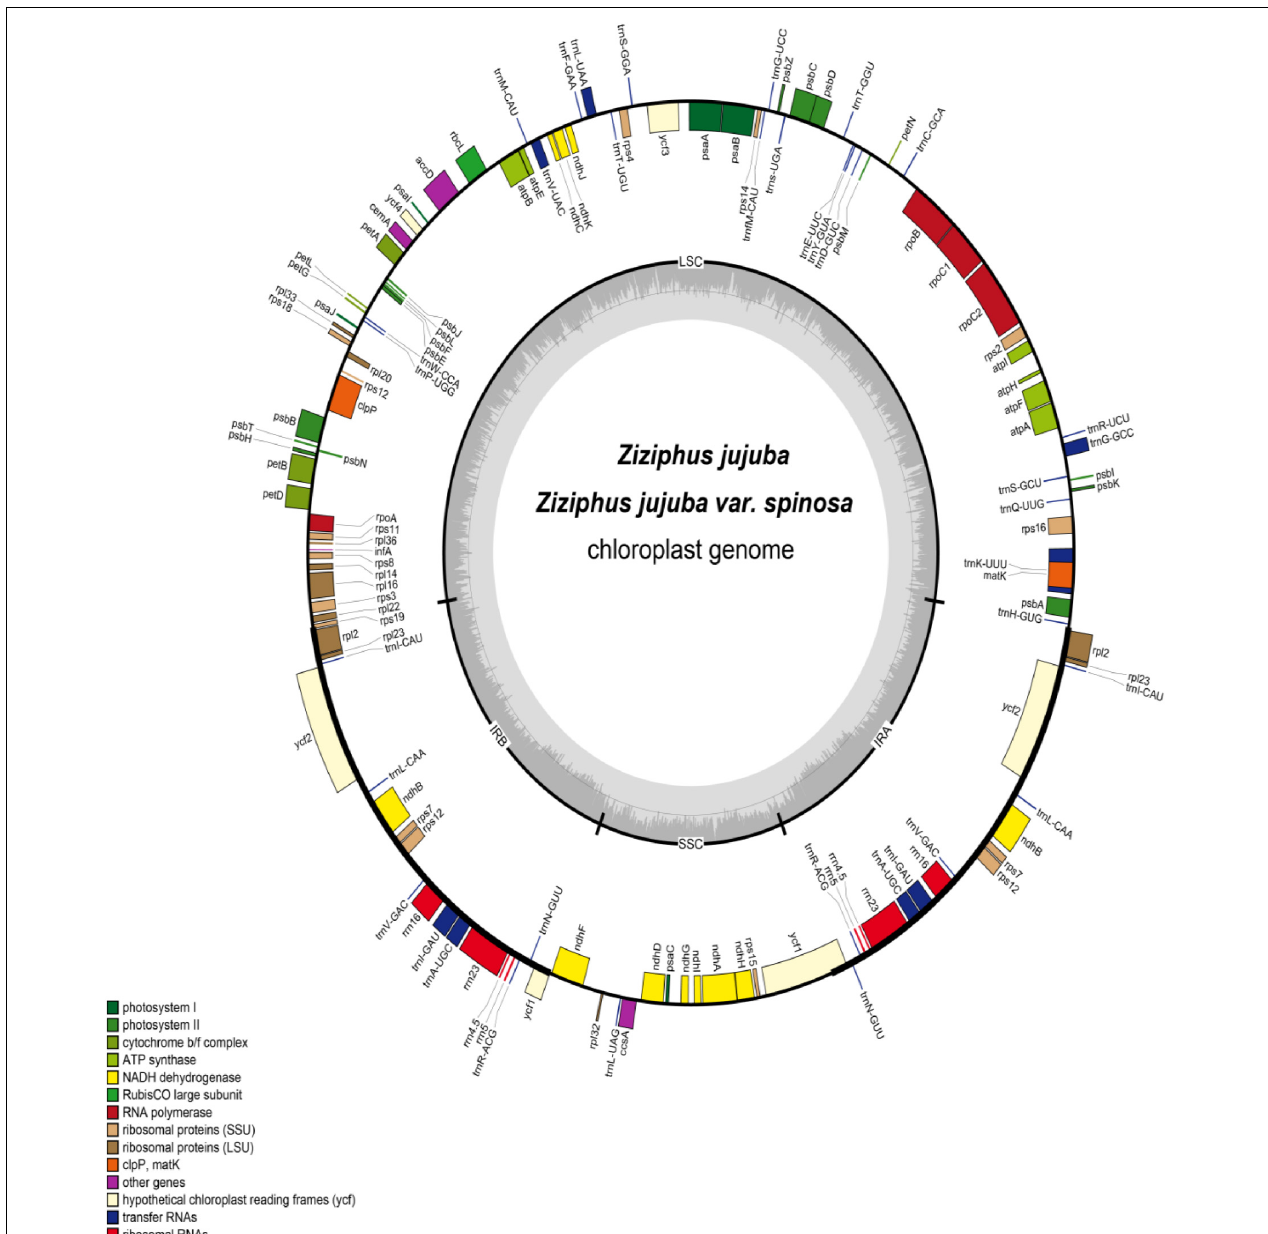
FIGURE 1 | Map of the Ziziphusjujuba and Ziziphusjujuba var. spinosa chloroplast genomes. Genes marked inside the circle are transcribed clockwise; genes marked outside the circle are transcribed counterclockwise. Colored shading indicates the gene functional groups. Innermost dark gray corresponds to the GC content; and light gray corresponds to the AT